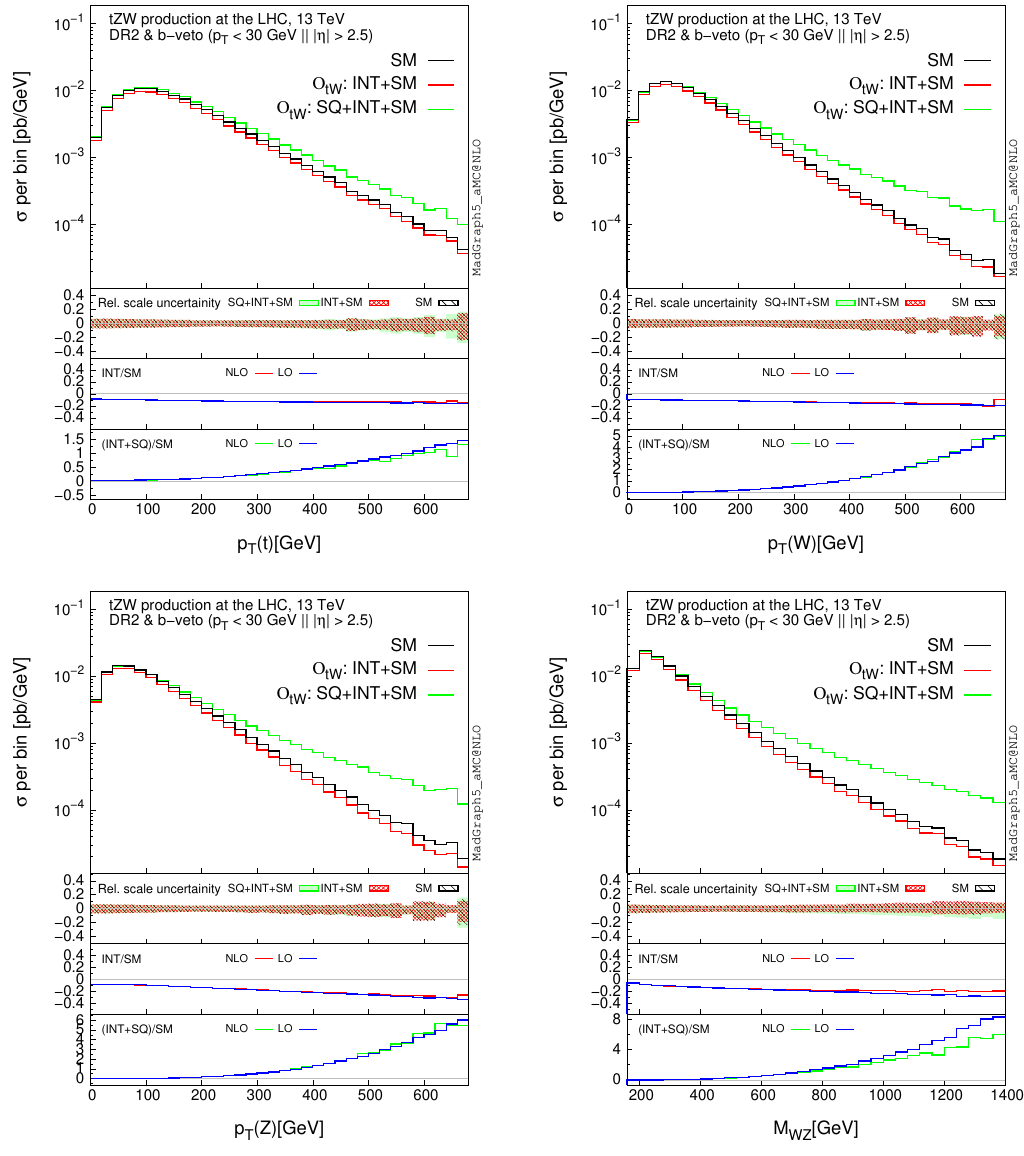
Figure 10 . Same as figure 9 but for the O